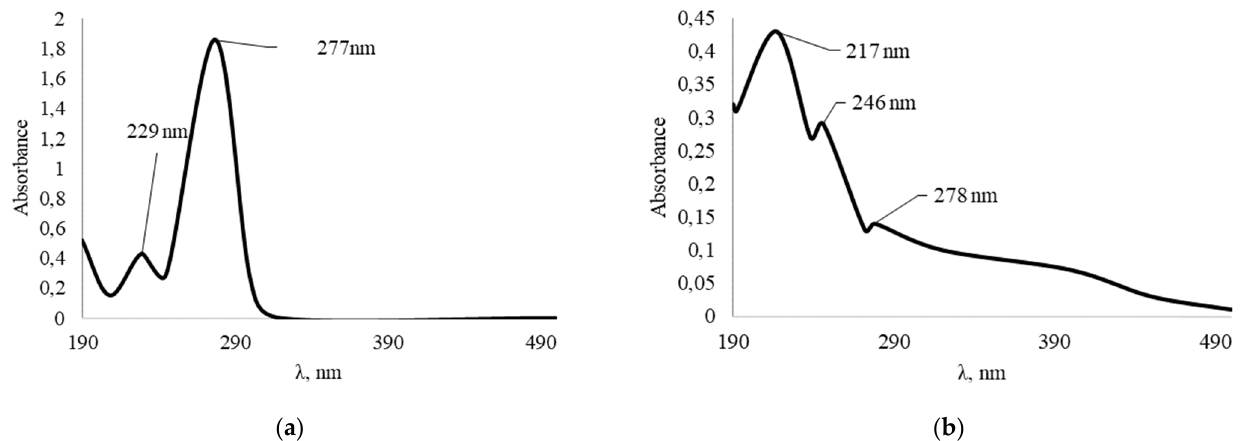
Figure 4. UV spectra of 2-furaldehyde: ( a ) control solution; ( b ) interaction with